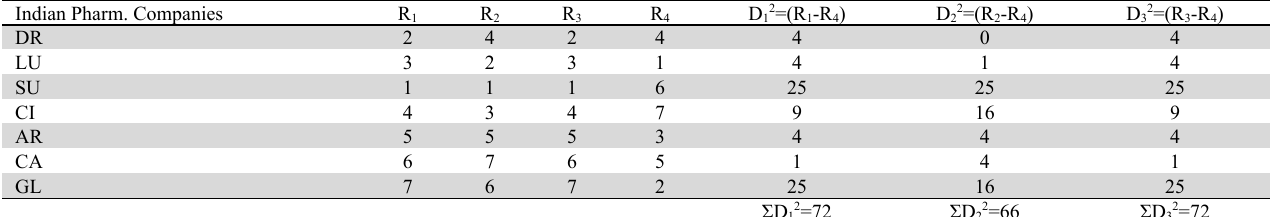
Firms' size determinants and Accounts payables days relational co-movement Indian Pharm. Companies